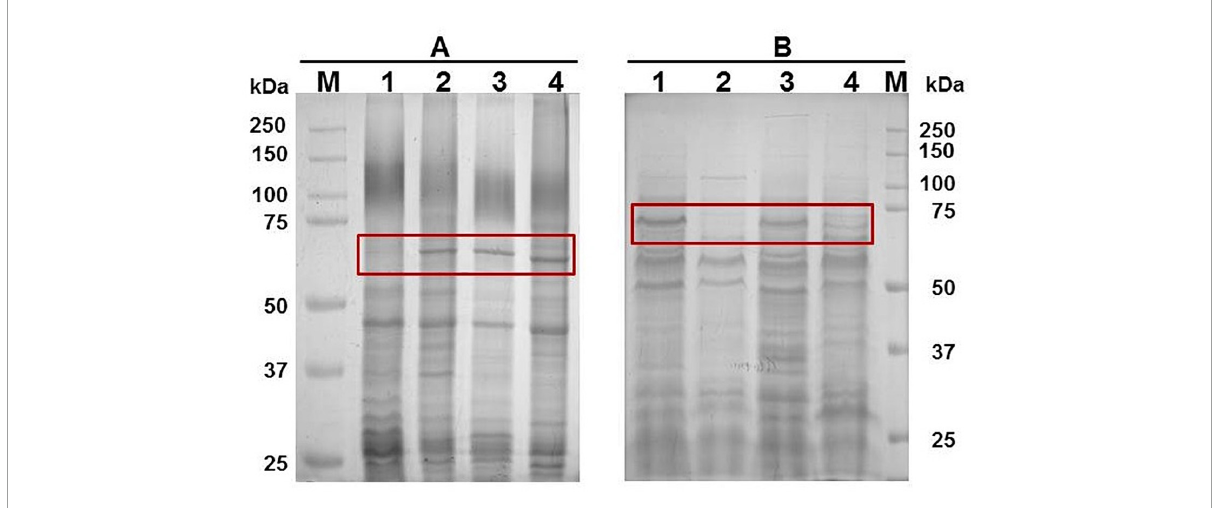
FIGURE6 Ten percent polyacrylamide gel showing the 1% Triton-insoluble (A) or soluble (B) protein patterns of G. anatis 12656 WT (lanes 1 and 2) and (cid:127) fur 126.13 (lanes 3 and 4) without (lanes 1 and 3) or with 2,2 (cid:48) -dipyridyl (lanes 2 and 4).